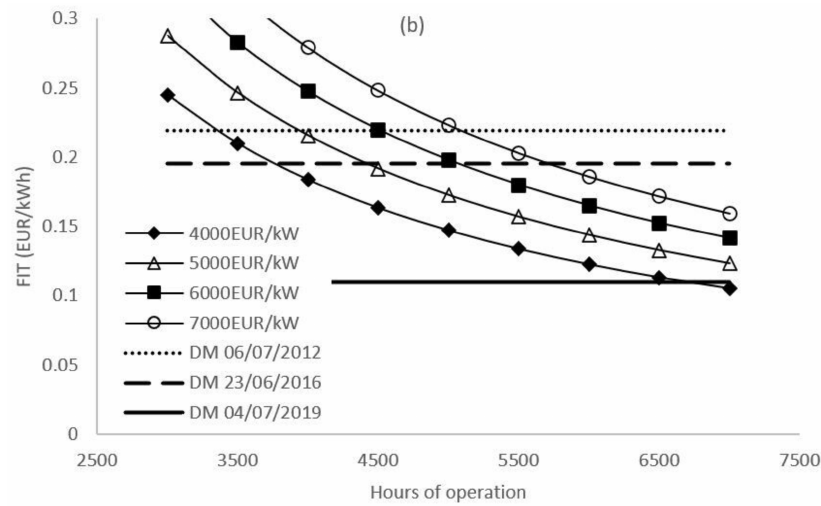
Figure 9. Feed in tariff vs. hours of operation for different capital expenditure values in order to reach internal rate of return of 7% ( a ) and 9% ( b ); plant size is 500 kW.